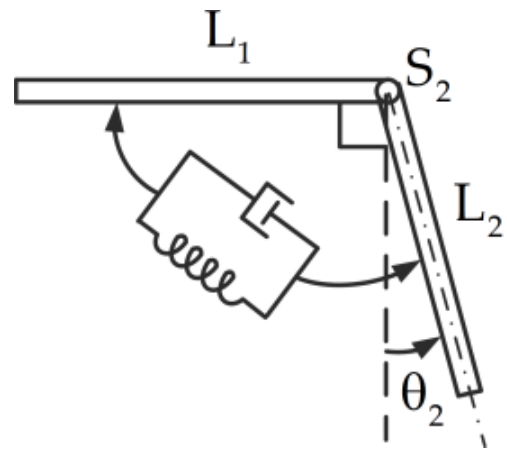
Figure 3. Schematic of the joint model.